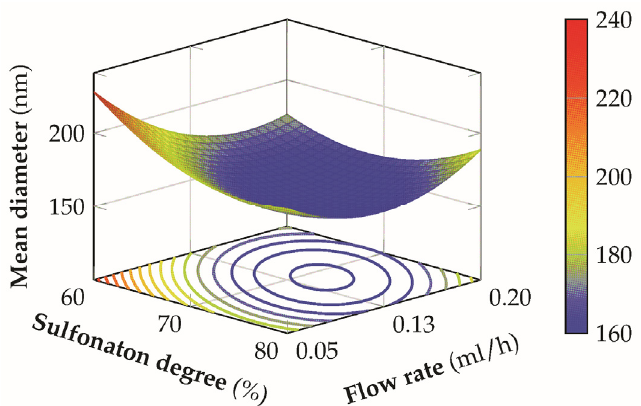
Figure 9. 3D response surface of the mean diameter for the sulfonation degree versus flow-rate at an applied voltage of 20 kV and at a distance of 14